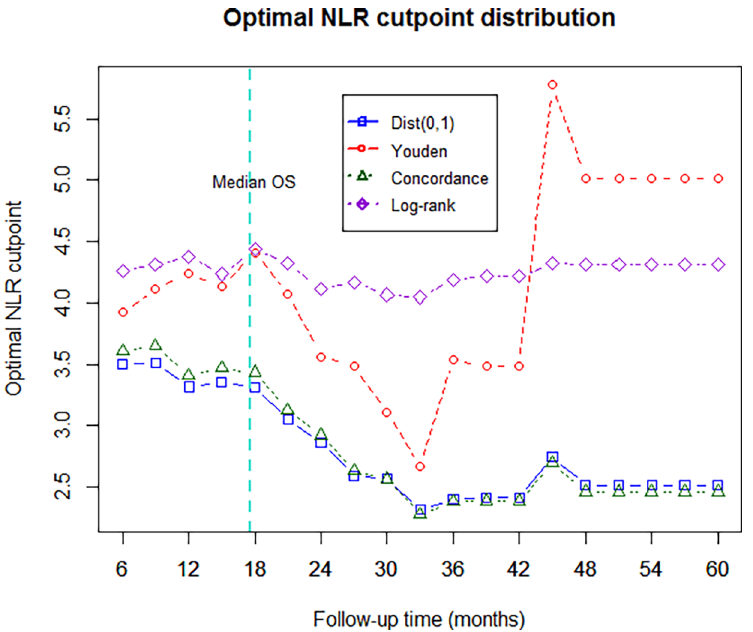
between 4.0 and 4.5.